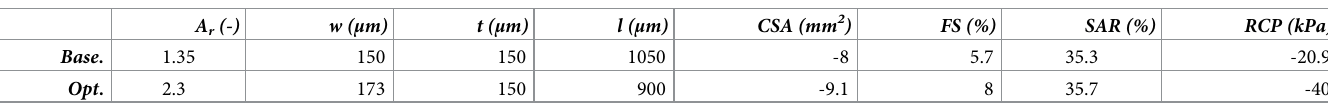
Table 7. Comparison between baseline (base.) and optimal (opt.) stent designs highlighting design parameters and their respective performance metrics. A r (-) w (μm) RCP (kPa) Base . 1.35 Opt .